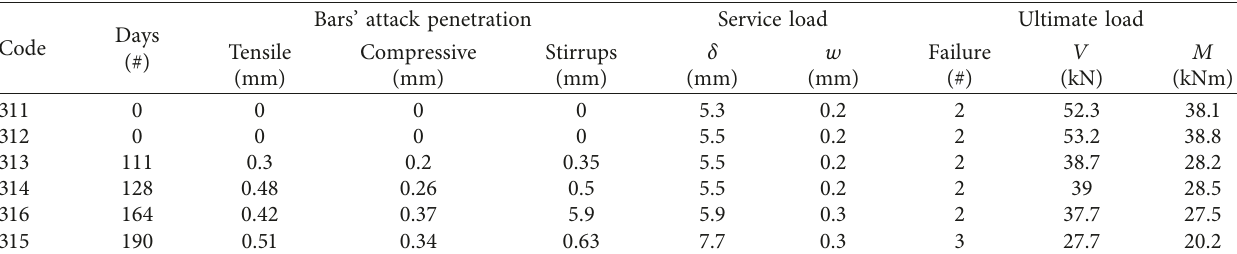
Figure 2: Geometry, reinforcement arrangement, and location of corrosion for the specimens tested by (a) Rodriguez et al. [6], (b) El Maaddawy et al. [7], (c) Zhu and François [8], and (d) Youn and Kim Table 1: Data of specimens tested by Rodriguez et al. [6].